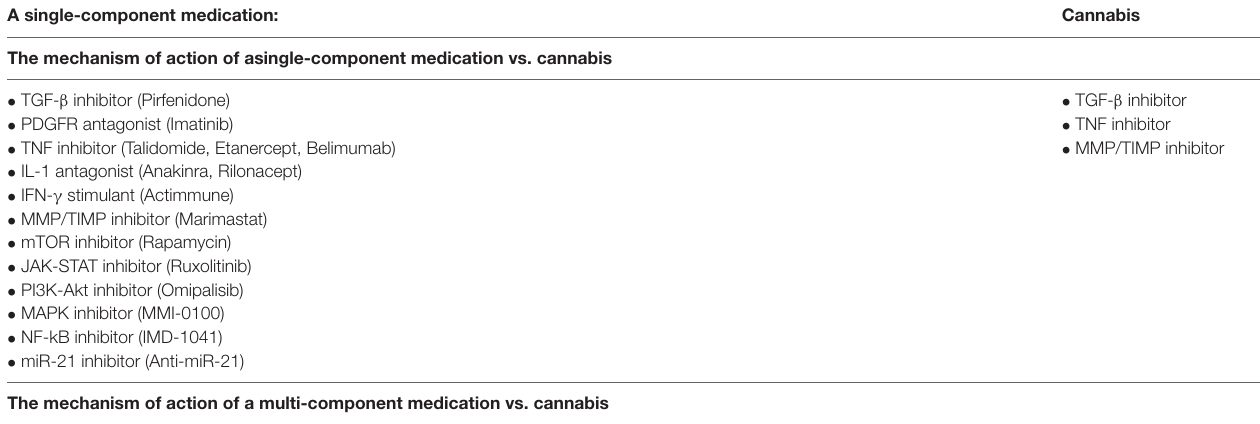
TABLE 5 | A comparison of target molecules in treatment of fibrosis using modern therapy vs. cannabis treatment. A single-component medication: The mechanism of action of asingle-component medication vs.